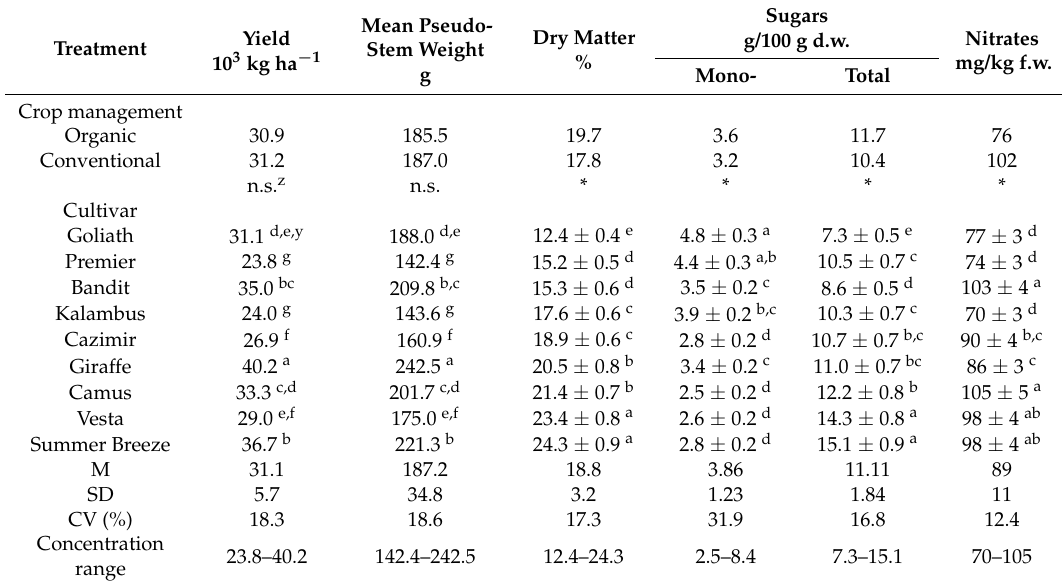
Table 1. Yield, mean pseudo-stem weight, and content of dry matter, sugars and nitrates in leek.